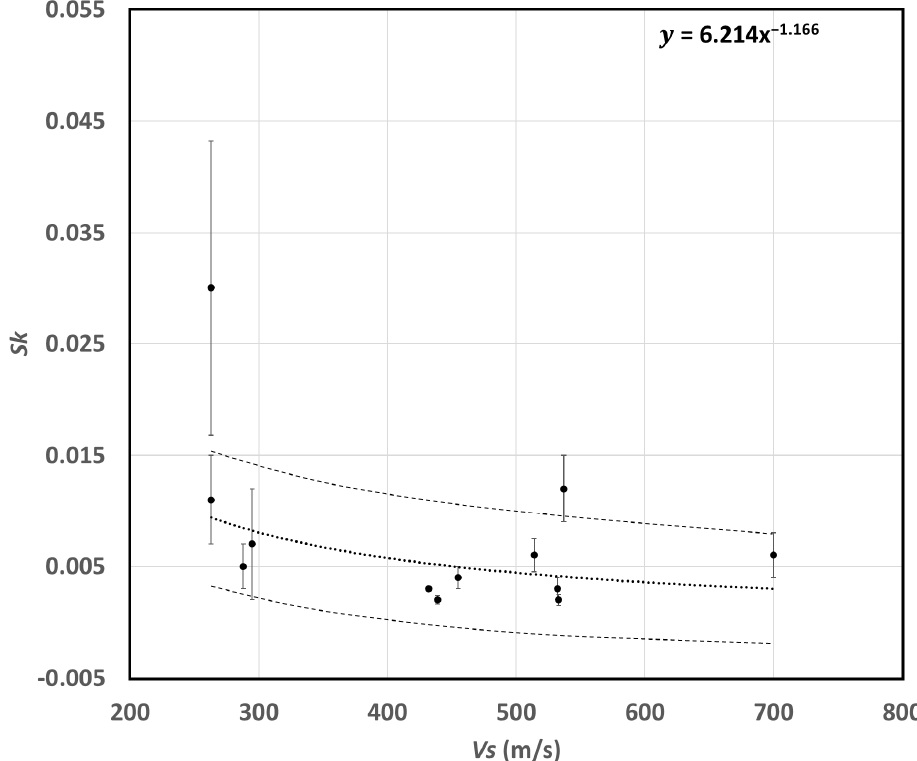
Figure 8. Relationship between storage coefficient ( Sk ) and S-wave velocity ( Vs ). The equation defines the central trend, indicated by the round dot line. Dashed lines define the ± 95% confidence interval of the trend. The error bars refer to the standard error of Sk.